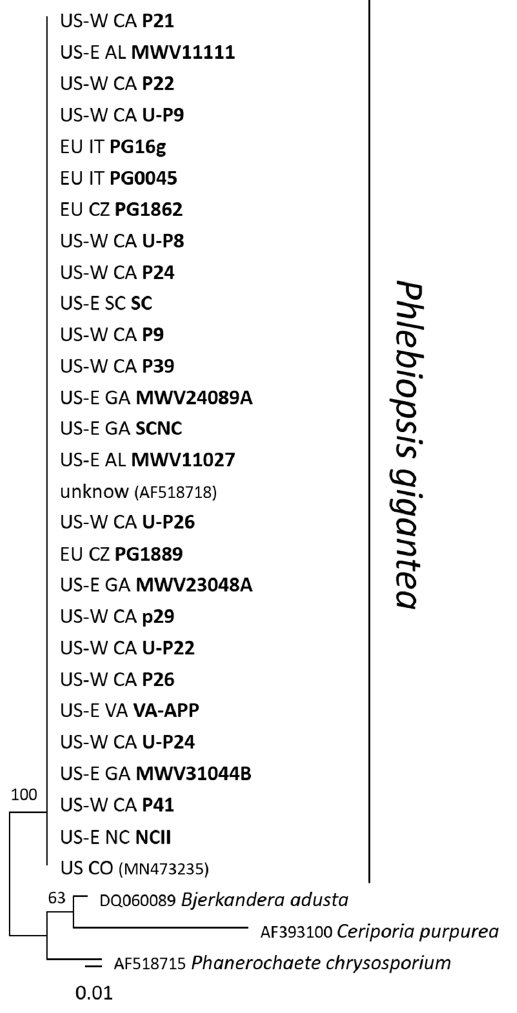
Figure 3. Maximum likelihood phylogram obtained from the partial large mitochondrial rRNA subunit (region between ML5 and ML6 ) sequence alignment of Phlebiopsis gigantea genotypes. Bjerkandera adusta, Ceriporia purpurea and Phanerochaete chrysosporium were used as outgroup taxa. ML bootstrap percentages ≥ 70% are given above clade branches. Labels indicate: geographic area, state, isolate code (in bold for sequences newly generated) and GenBank code brackets for sequences retrieved from NCBI.